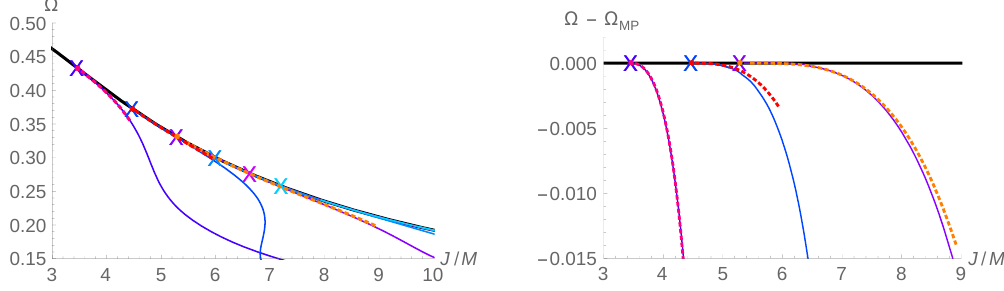
Figure 9 . Mass pro(cid:12)les for branches with ( N; m ) = (0 ; 4) (left) and ( N; m ) = (1 ; 6) (right).